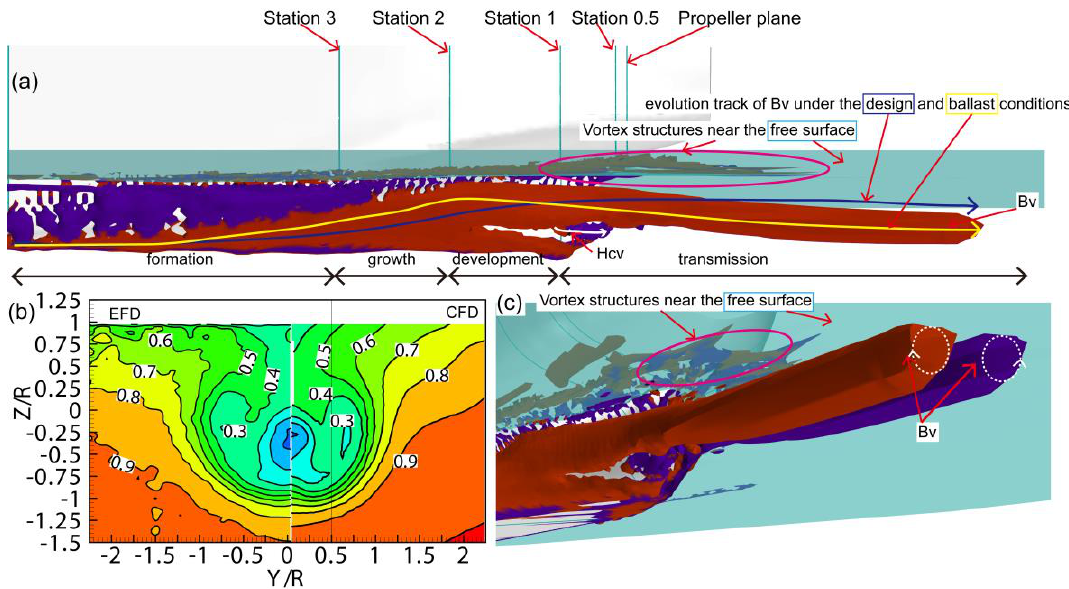
Figure 14. The vortex evolution of Panama bulk carrier under the ballast condition based on CFD: ( a ) The global evolution of the vortex structure; ( b ). Comparison chart of numerical and PIV result; ( c ) Close-up of the vortex structure.